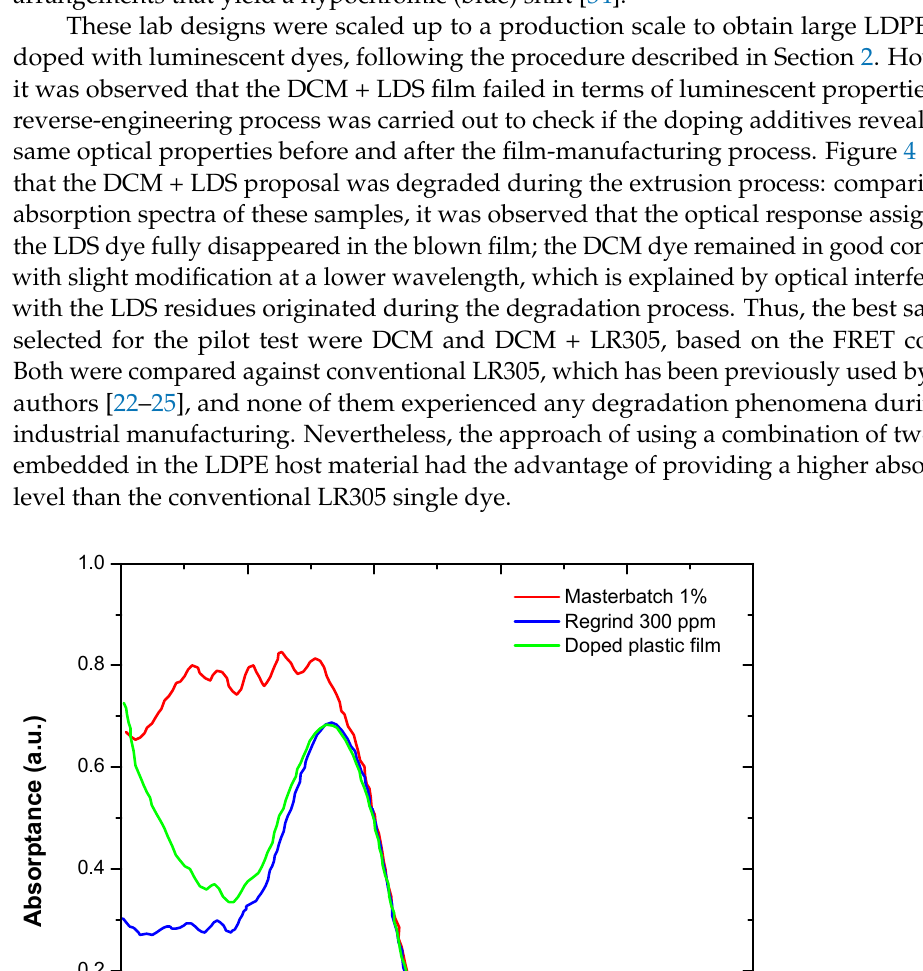
Figure 3. Absorption and emission spectra obtained for different dyes: ( a ) DCM, ( b ) LR305, ( c ) LDS, ( d ) DCM + LDS, and ( e ) DCM + LR305. Emission peaks were aligned with PAR requirements, and combination of DCM + LDS offered the advantage of wider absorption spectra.